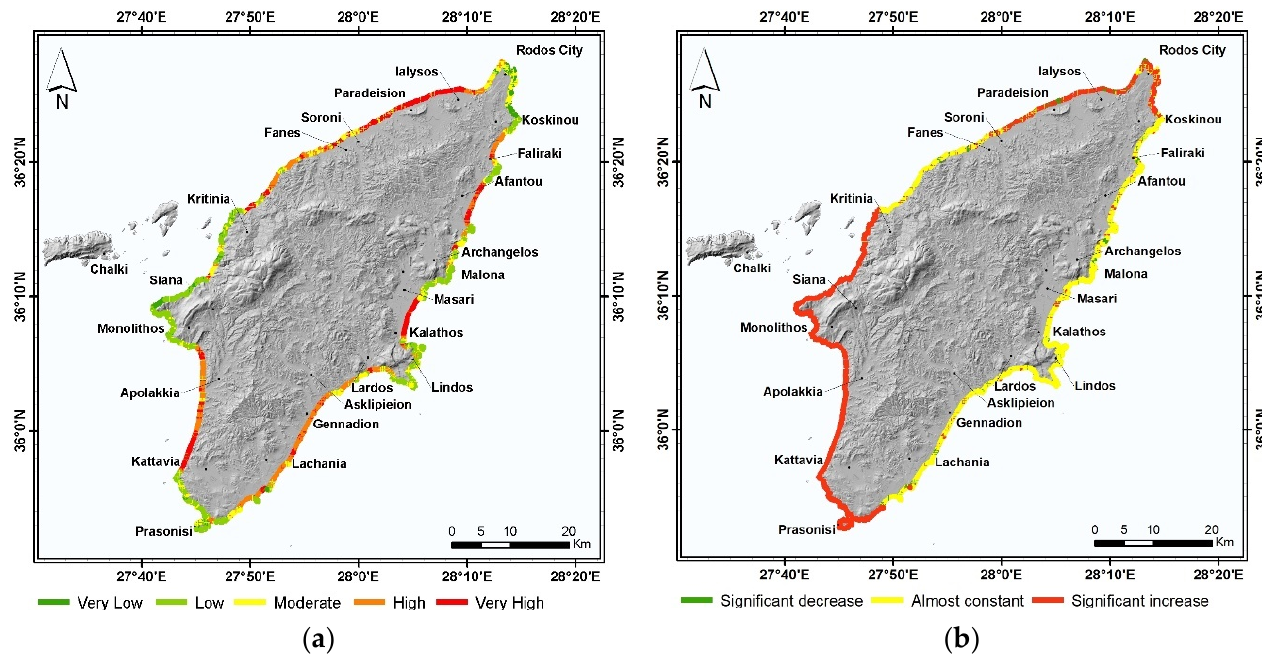
Figure 10. ( a ) Assessment of the current coastal vulnerability in Rhodes Island due to the ongoing sea level rise. ( b ) Evolution of the Rhodes coastal vulnerability until 2100.